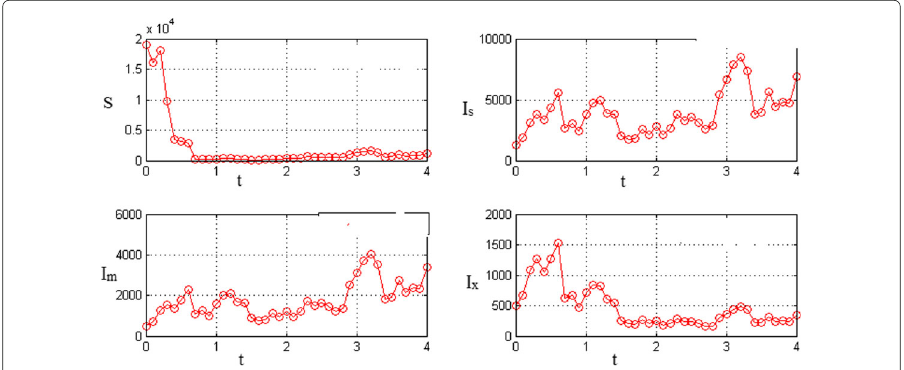
Fig. 7 The approximate solutions with θ = 0.9, ξ = 1, h = 0.1, by using